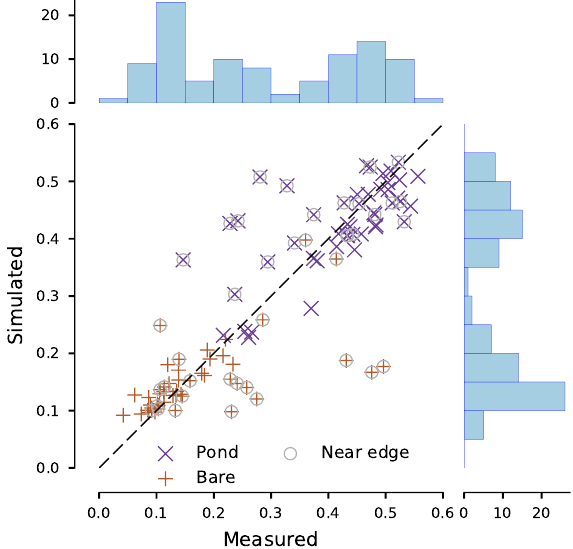
Figure 5. Simulated values versus measured values of bulk trans- mittance (Eq. 4) (400–900nm) for all three transects. The black dashed line indicates a 1 : 1 correspondence. Blue crosses are for ponded ice; red plus signs are for bare ice. Data from locations close to edges of ponds are marked with grey circles. On top is a histogram for observed values and on the right is one for simulated